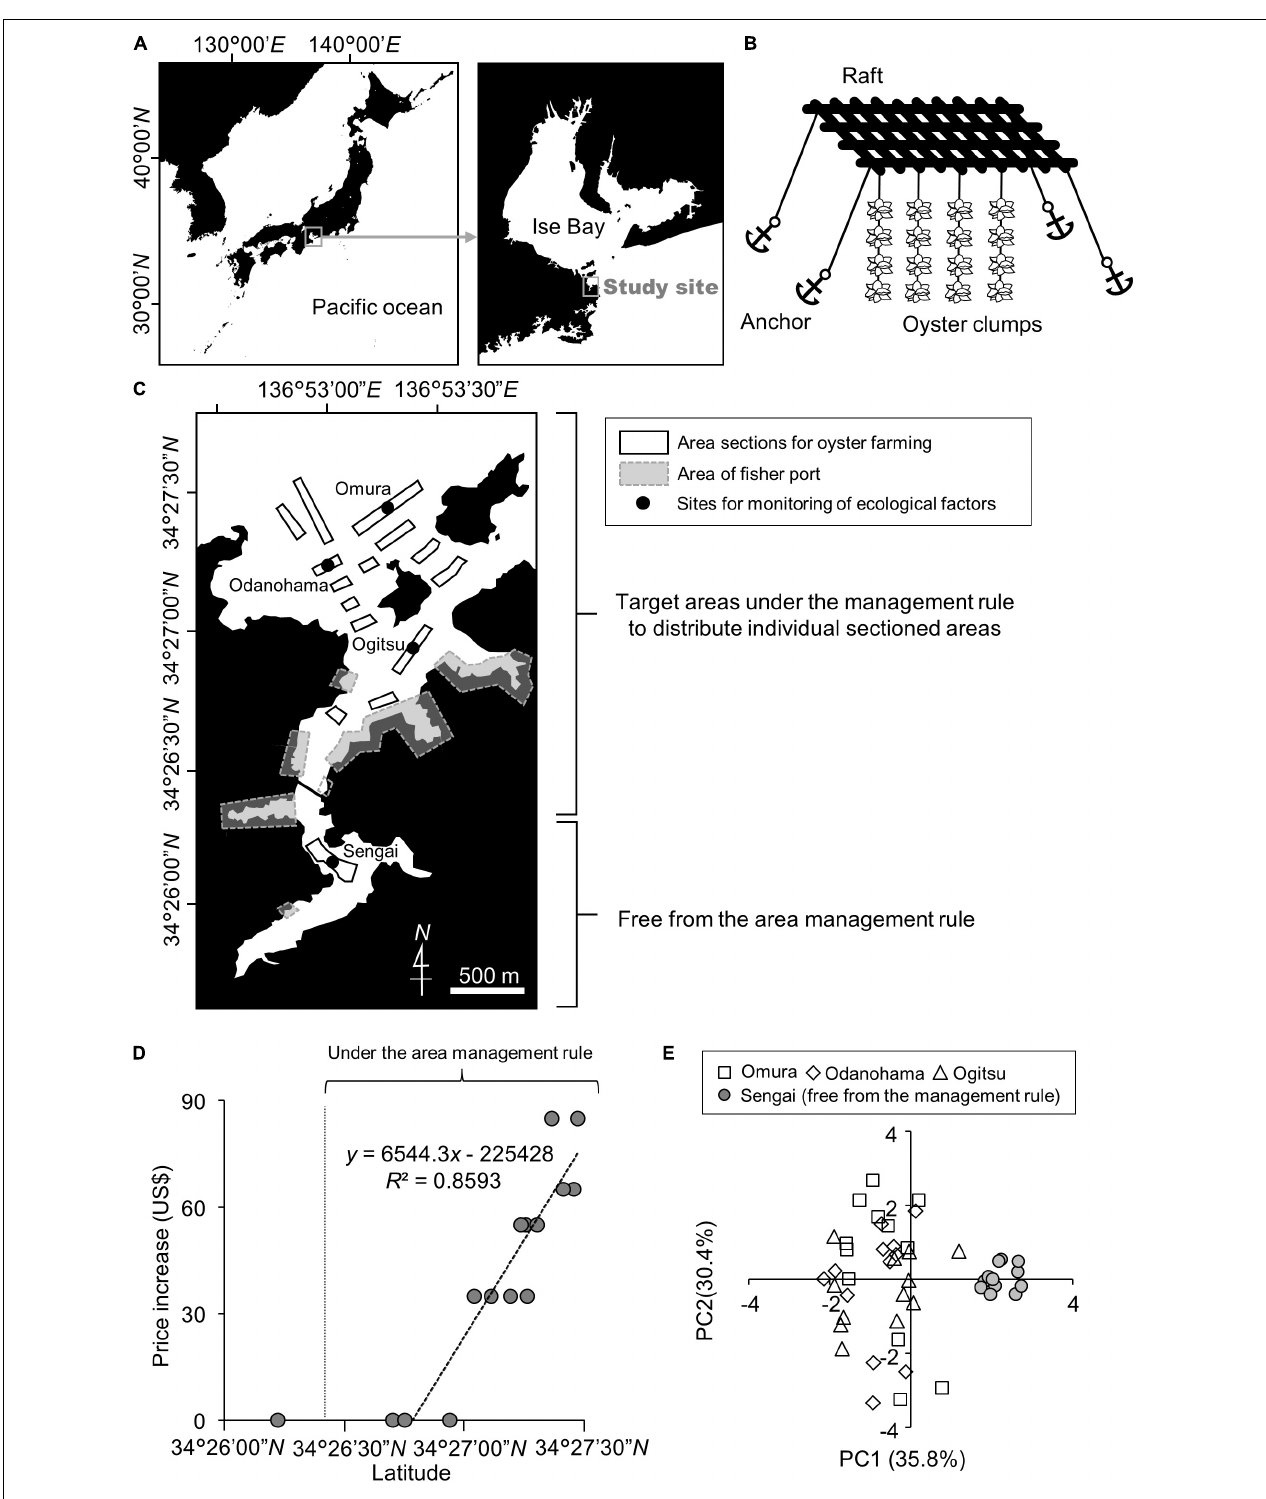
FIGURE 1 | Changes in the economic values and environmental characteristics of the area sections for oyster farming in the study area. (A) Map indicating the study site. The original map of Japan was obtained from the web system for generating a map, CraftMap (http://www.craftmap.box-i.net/). (B) Hanging culture method for oyster farming at the study site. (C) Map of the sectioned marine areas for oyster farming at the study site. (D) Correlation between the latitude and the increase in the usage fee for a single area section ( t -test for Pearson’s correlation coefficient; P < 0.05). The number of the plots corresponds to the number of the area sections in Figure 1C . (E) Biplot of the principal component scores representing the differences in environmental conditions between the area with area management rules (white squares and triangles) and that free from management (gray circles).